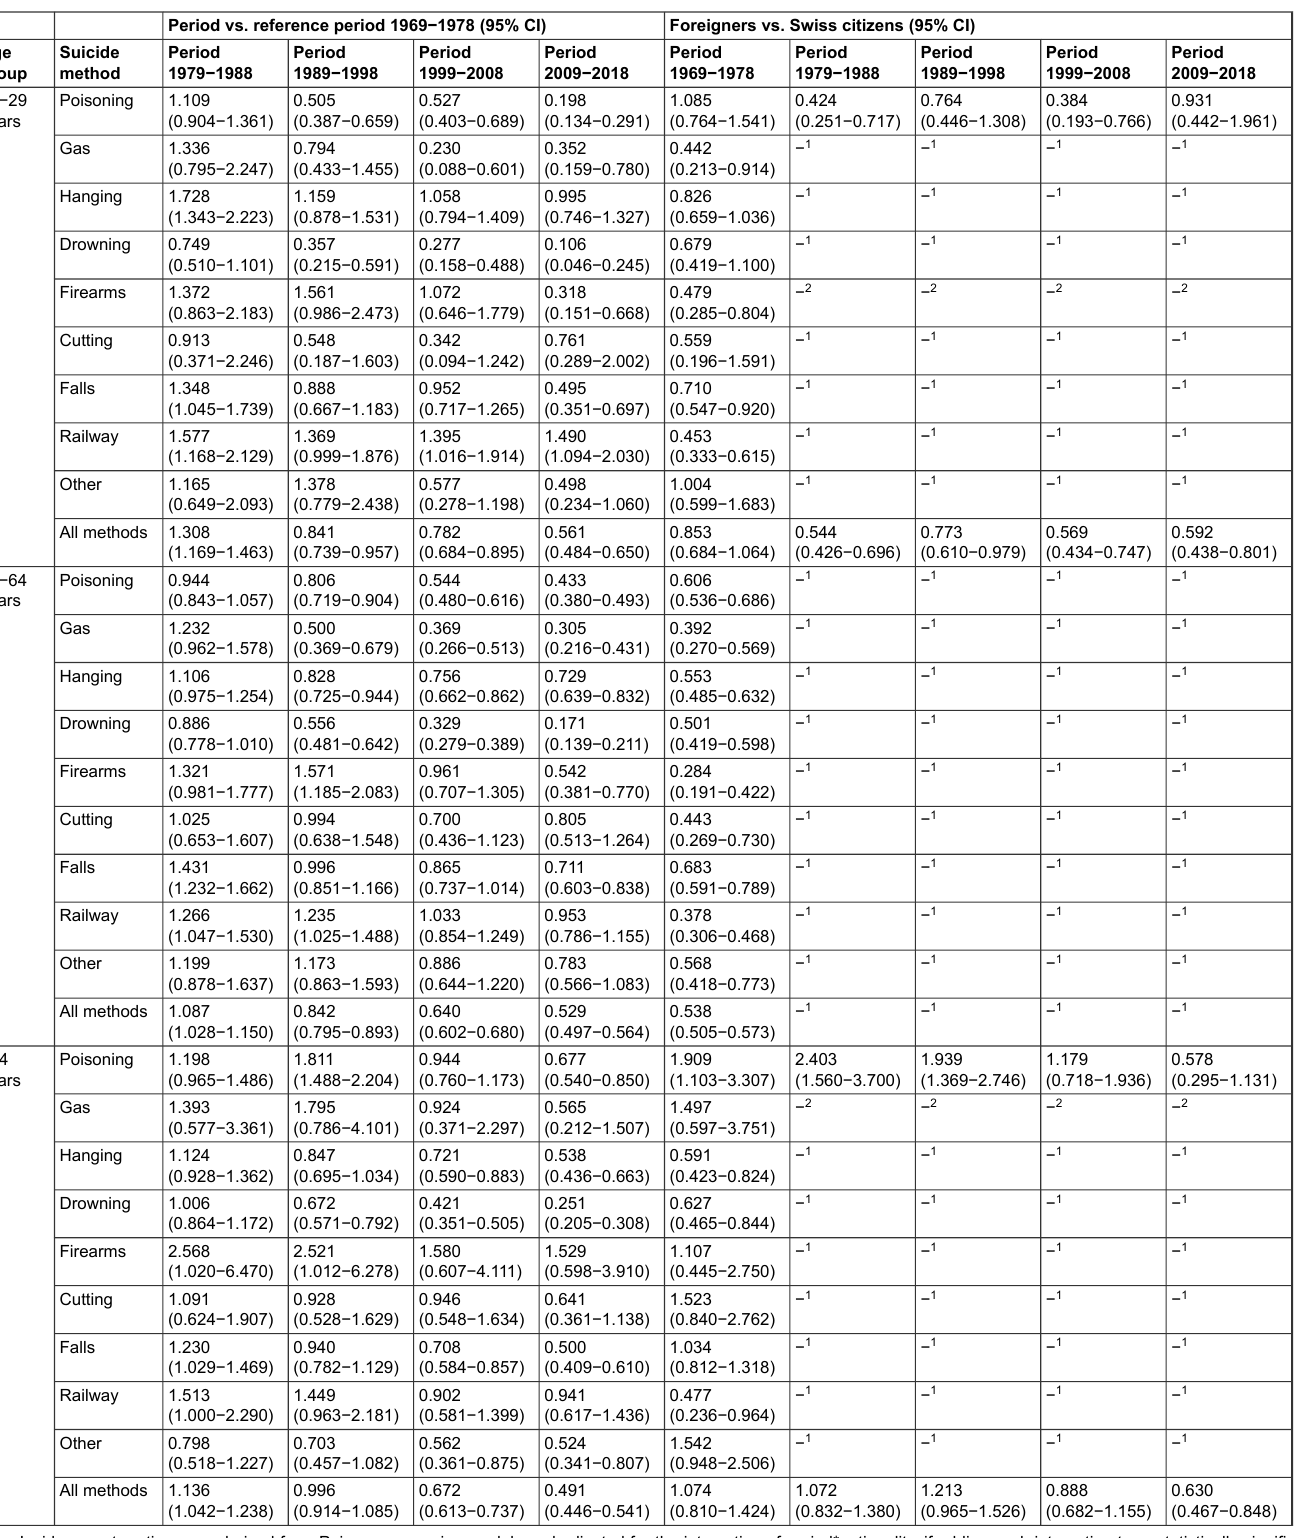
Table 4: Rate ratios of suicides in